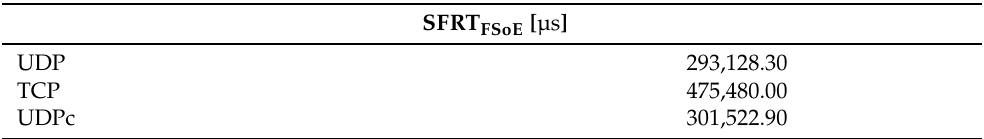
Table 5. SFRT values for the three transport